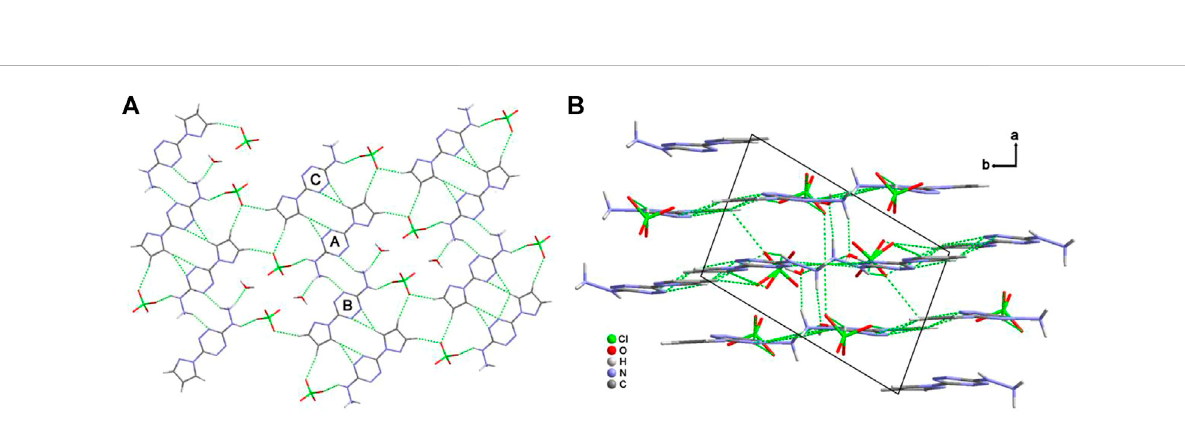
The two-dimensional hydrogen-bonding network along the b axis of 4 · H 2 O (A) and the crystal packing along c axis of 4 · H 2 O (B)